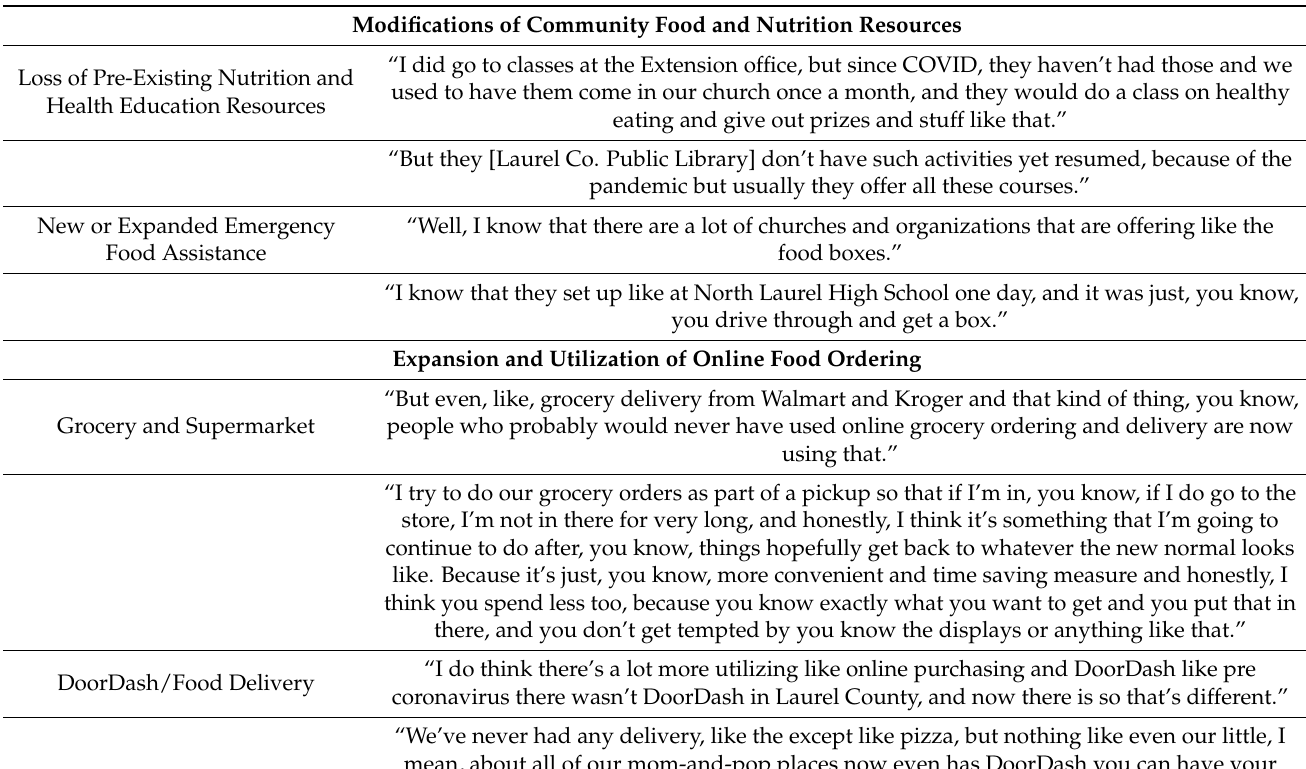
Table 2. Changes in food environment identified by focus group participants in Laurel County, Kentucky, April